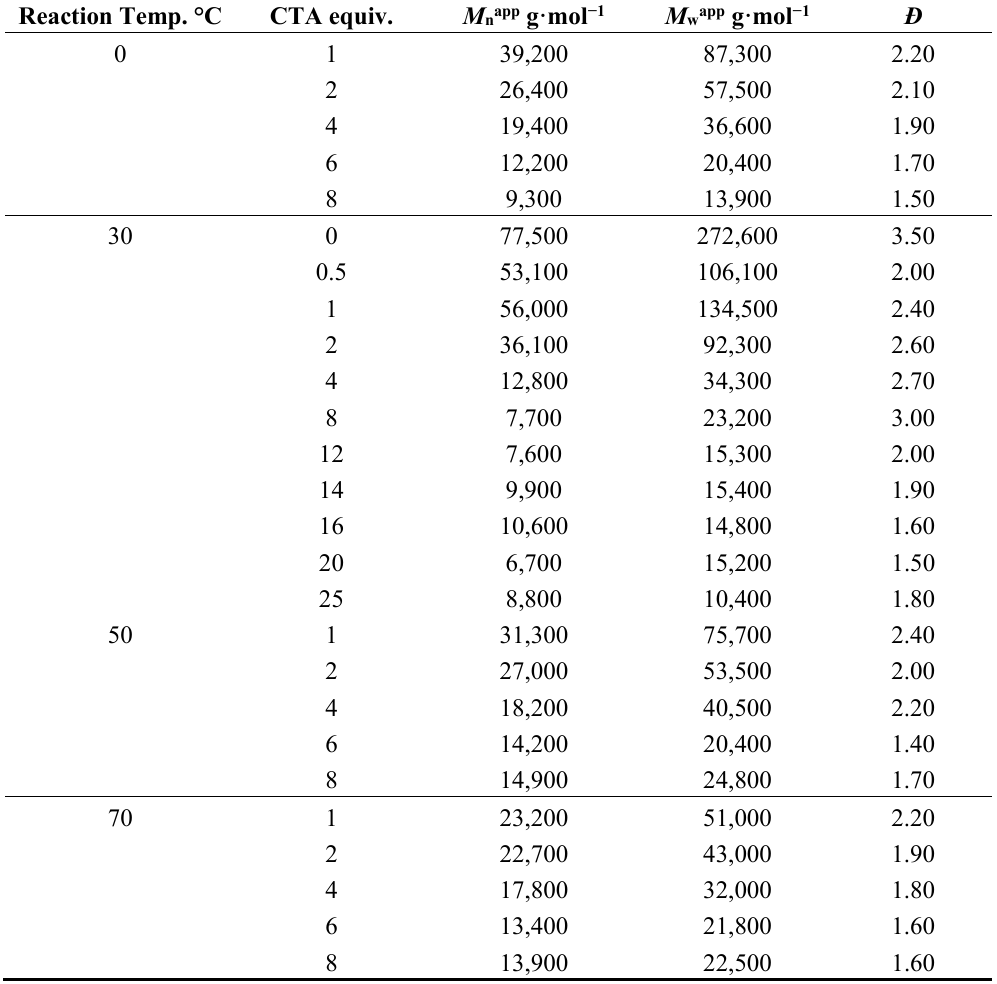
Table A1 . Overview of SEC results of conjugated MDMO-PPV using different equiv. of CBr 4 at varying reaction temperatures. Reaction Temp. °C CTA